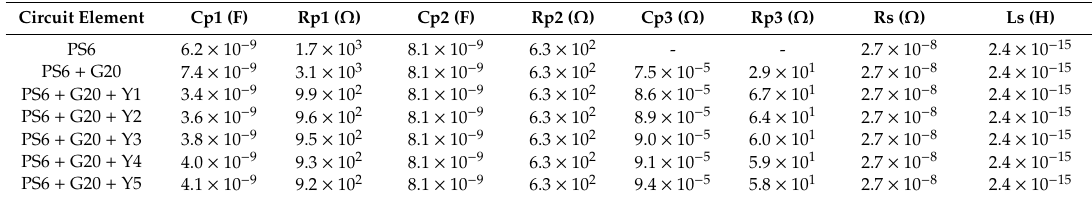
Table A11. Modeled impedance parameters Cp1, Rp1, Cp2, Rp2, Cp3, Rp3, Rs, and Ls of biochip PS6, with 10% glucose as medium and S. cerevisiae .